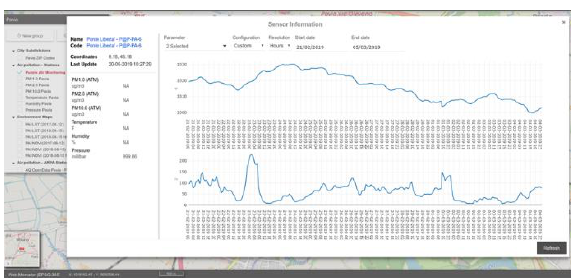
Figure 16. Temperature and PM25 trends for a PurpleAir monitoring station in Pavia